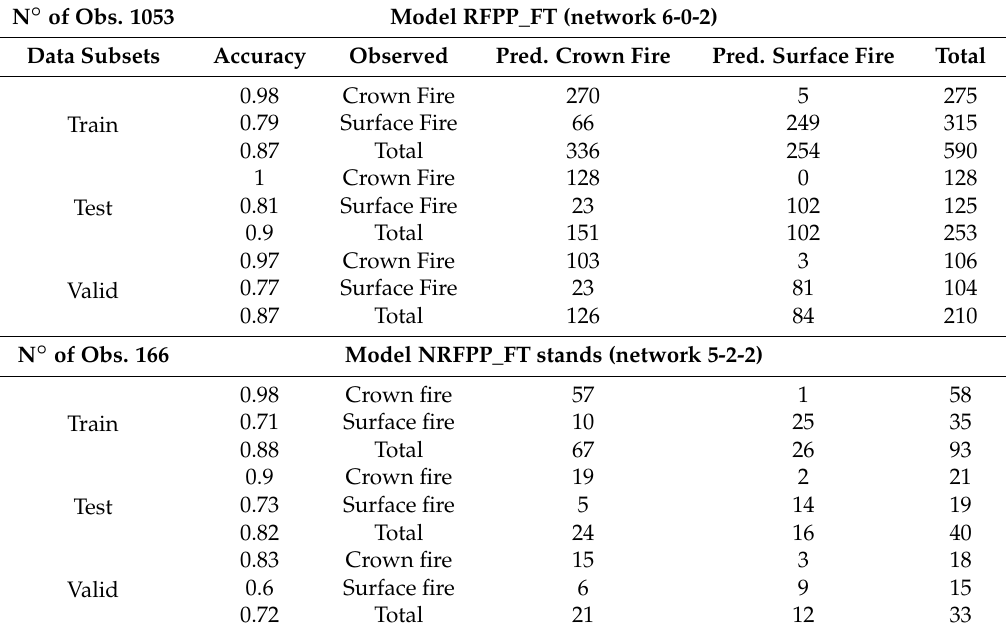
Table 8. Best model architecture and confusion matrix for the classification of Fire Type within reforested and not reforested stands of P. pinaster . N ◦ of Obs.